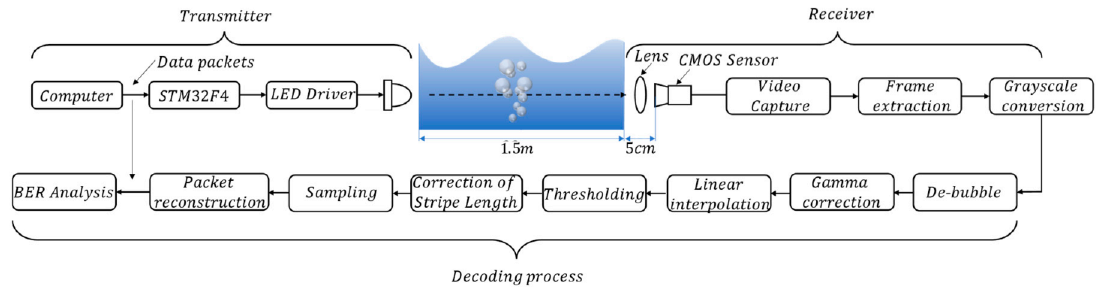
Figure 4. Block diagram of the rolling shutter effect (RSE)-based underwater optical camera communication (UOCC) system for the experiment.